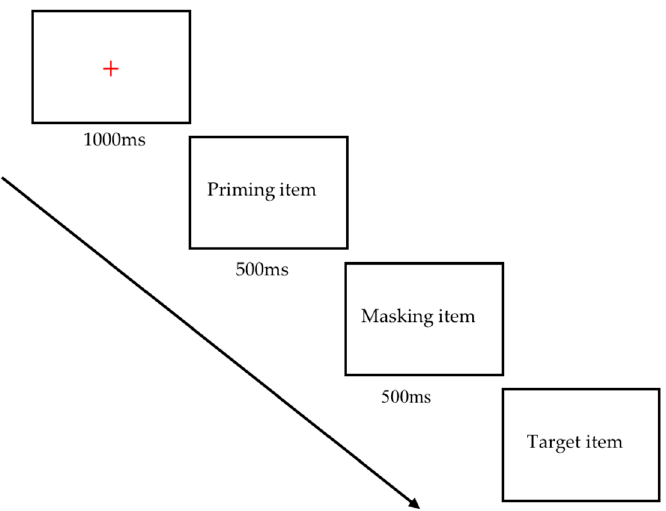
Figure 5. A trial in the priming task.